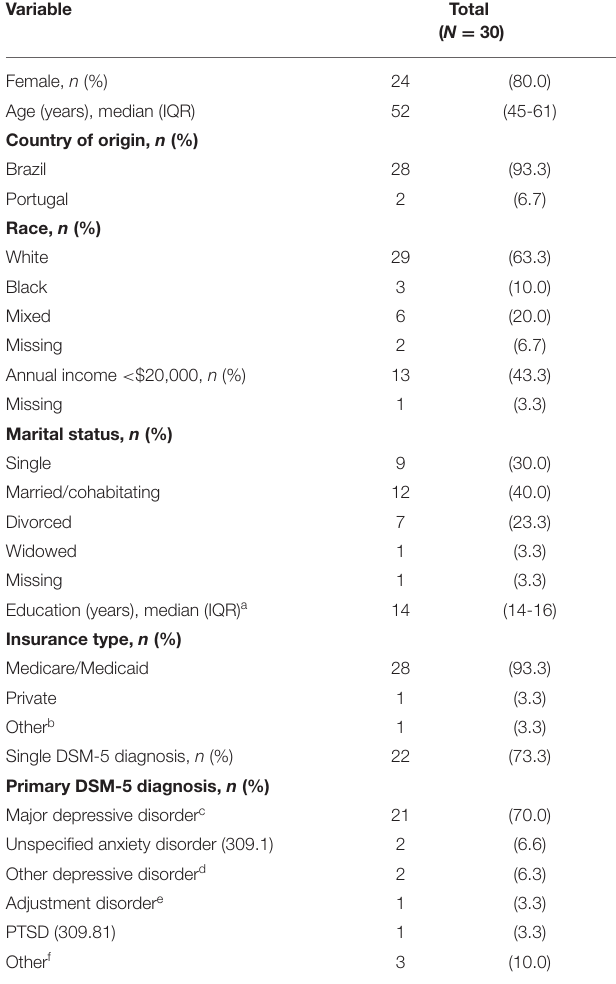
TABLE 2 | Baseline demographic and clinical characteristics of